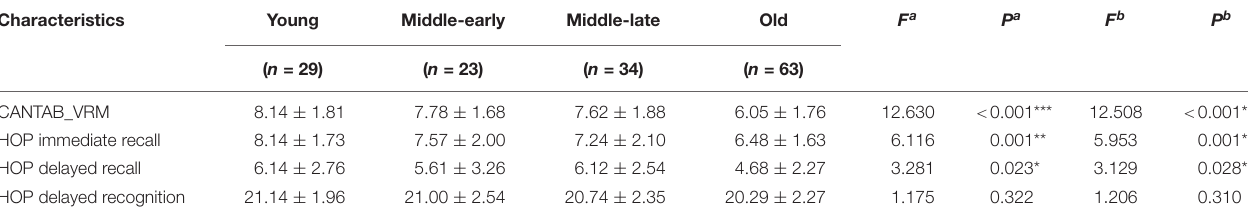
TABLE 3 | Neuropsychological tests scores.